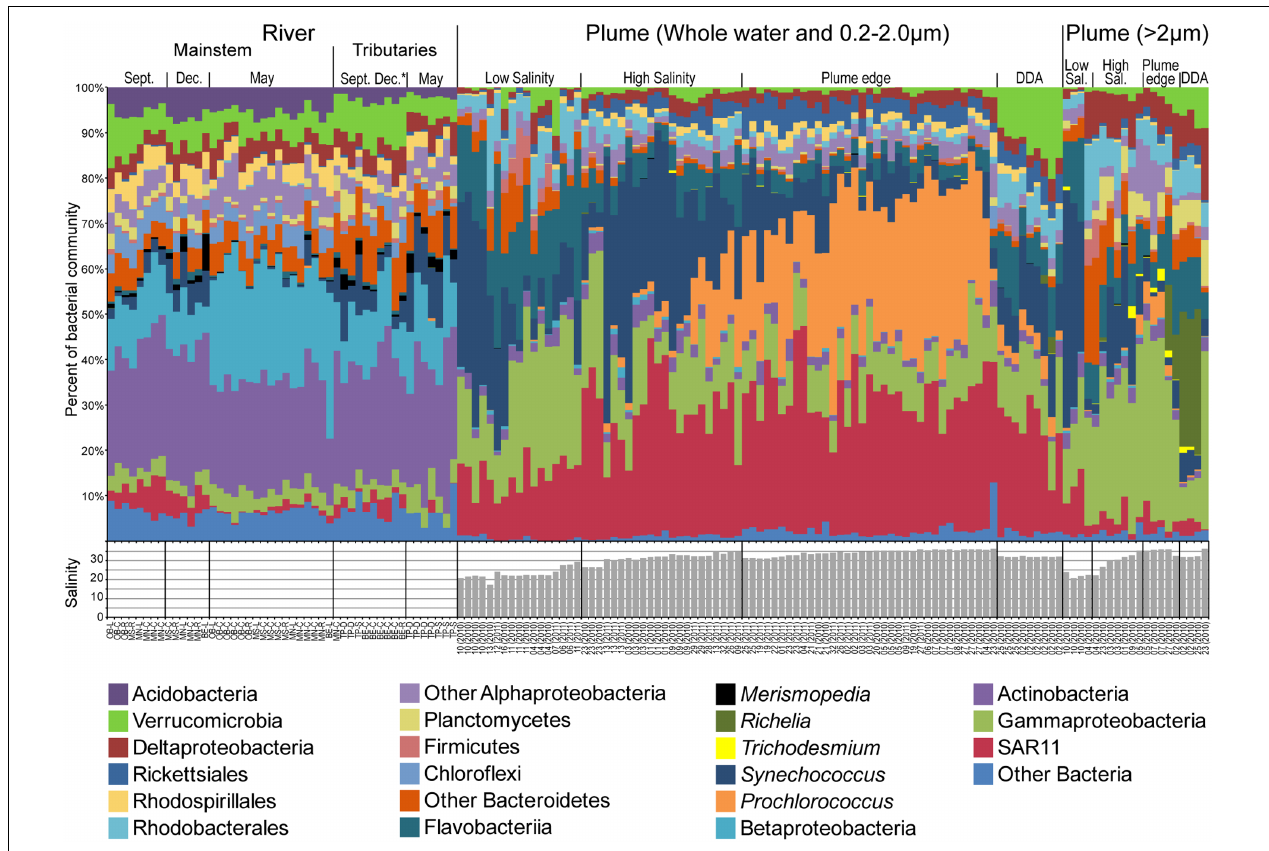
FIGURE 3 | Taxonomic diversity and salinity of Amazon River and Plume samples grouped by environment following Figure 2, and showing the most abundant taxonomic groups. River samples are ordered by month in the mainstem river (Óbidos and Macapá), and tributary stations (Belém and Tapajós). Plume samples are ordered by environmental group for the 0.2–2.0 µ m and whole water samples, followed by the > 2.0 µ m fraction